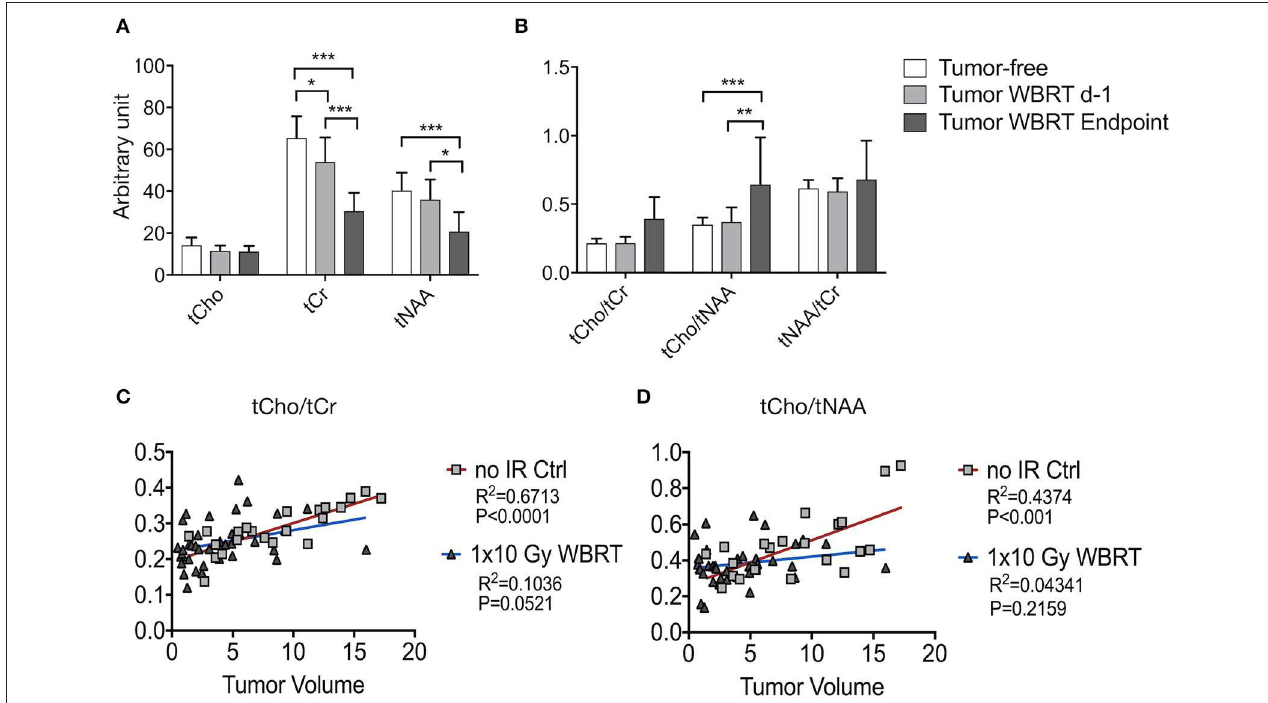
FIGURE 6 | MRS data and its correlation with volumetric measurements by MRI (A,B) Signal intensity of tCho, tCr, tNAA (A) and ratio of tCho/tCr, tCho/tNAA, and tNAA/tCr (B) in wild-type mice and tumor-bearing mice at d-1 before WBRT and in end-stage tumors (depicted as arbitrary units). (C,D) Correlation between tumor volume and metabolite levels for untreated tumor bearing animals and after WBRT. Shown are graphs for tCho/tCr (C) , tCho/tNAA (D) and tumor size ranging from 0.5 to 20 mm 3 . Data are presented as mean ± s.d.. P -values were obtained using two-way ANOVA and unpaired two-sided Student’s t -test. Correlation between tumor volume and metabolic parameter was determined by linear regression coefficient and goodness of fit is presented as R 2 . n.s. = not significant, * P < 0.05, ** P < 0.01, *** P <